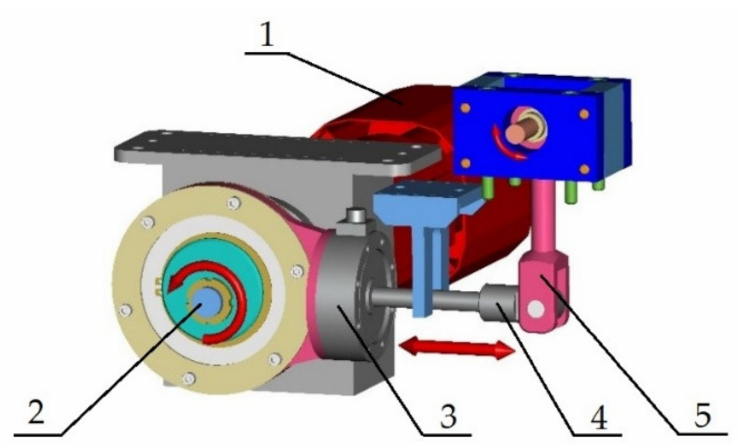
Figure 4. The 3D model of the designed mechanism for cyclic loading the tested material by torsion: 1—servomotor SEW-EURODRIVE CFM71M; 2—eccentric system; 3—scanner of force; 4—capstan; 5—crank.